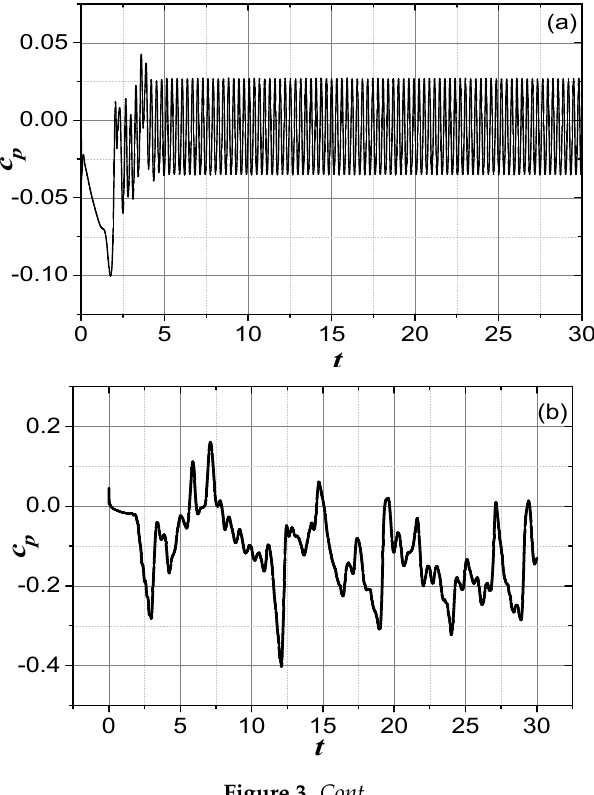
Figure 3. Waveforms of the three types of signals (( a ) circular target; ( b ) triangular target; ( c ) square target). 3. Target Recognition Strategy 3.1. Feature Selection for Shape Classification 3.1.1. Phase Space Reconstruction The dynamic characteristics of a times series can be revealed by the chaos attractor, and we can use it to estimate whether the system is chaotic or stochastic. Therefore, attractor reconstruction is a key step in chaotic time series analyses. In order to reveal its chaos attractor, a high-dimensional space is built to express the time series of the pressure signal, a method which was proposed by Takens